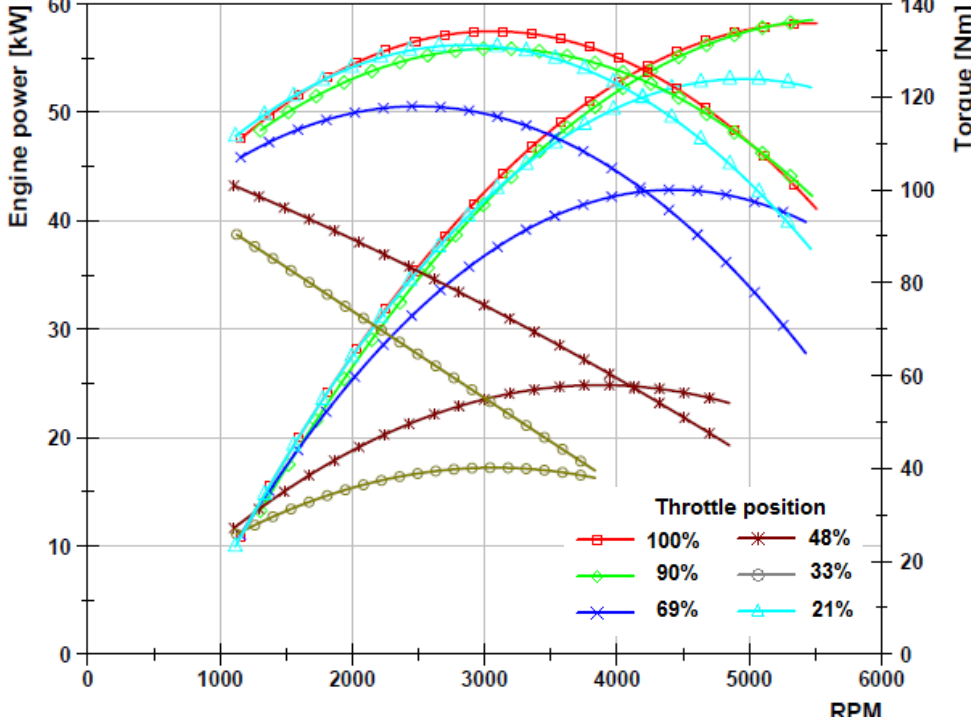
Figure 3. Engine torque and power curves for various with a 7% mass fractions of DME at WOT.